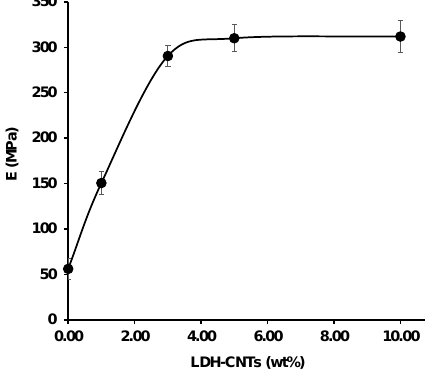
Figure 7. Elastic modulus, E (MPa), as a function of filler loading.